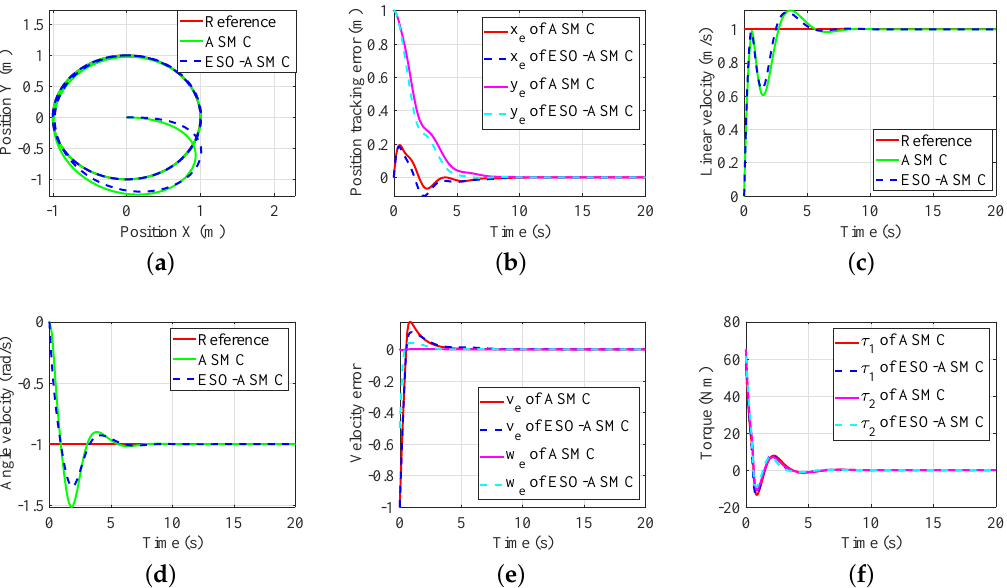
Figure 4. Circular trajectory tracking for WMR considering skidding and slipping. ( a ) Trajectory tracking. ( b ) Position tracking error. ( c ) Linear velocity tracking. ( d ) Angle velocity tracking. ( e ) Velocity tracking error. ( f ) Control input.